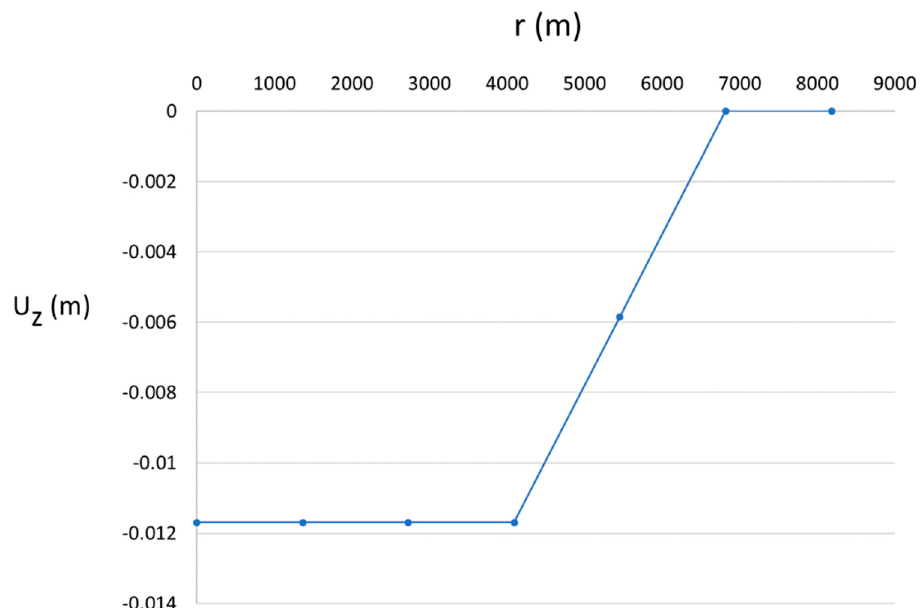
Figure 4. The allure of the predicted vertical displacement of the surface (u z ) in meter versus the distance (r) in meter from the vertical axis of the reservoir in the Atsimo Andrefana region.